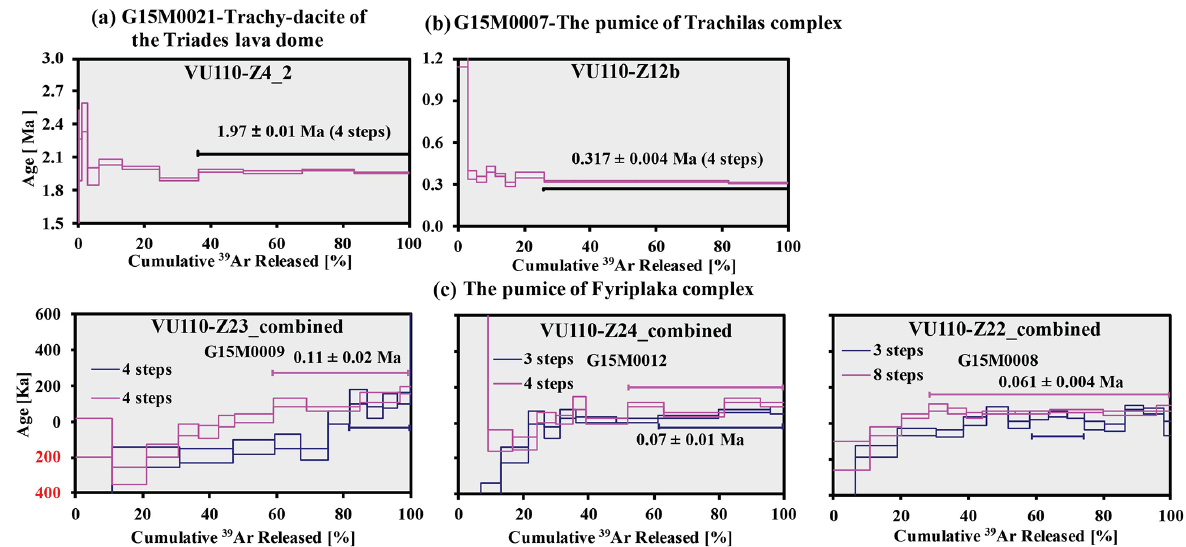
Figure 8. Biotite 40 Ar / 39 Ar plateau ages for samples G15M0021 (a) , G15M0007 (b) , and G15M0009 (VU110-Z23_combined), G15M0012 (VU110-Z24_combined) and G15M0008 (VU110-Z22_combined) (c) . The numbers in red represent negative ages. Individual steps and final age calculation are reported with 1 σ errors. The Triades lava dome, Trachilas and Fyriplaka complexes are located in the north-western, northern and south-eastern parts of the Milos VF, respectively (see Fig. 2). See the individual steps of samples G15M0021, G15M0007, G15M0009, G15M0012 and G15M0008 in Supplement file II.